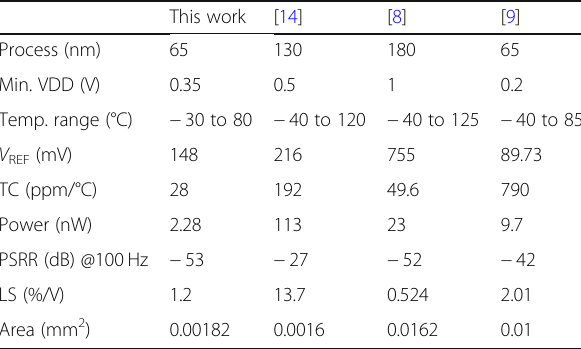
Table 1 Performance summary and comparison